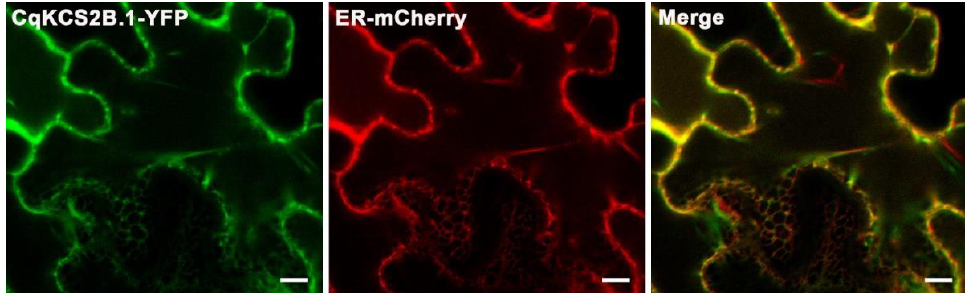
Figure 3. Localization of CqKCS2B.1 -YFP in the endoplasmic reticulum. Signals of CqKCS2B.1 -YFP and ER-mCherry were merged in the epidermal cells of Nicotiana leaves. Bar = 10 µm.